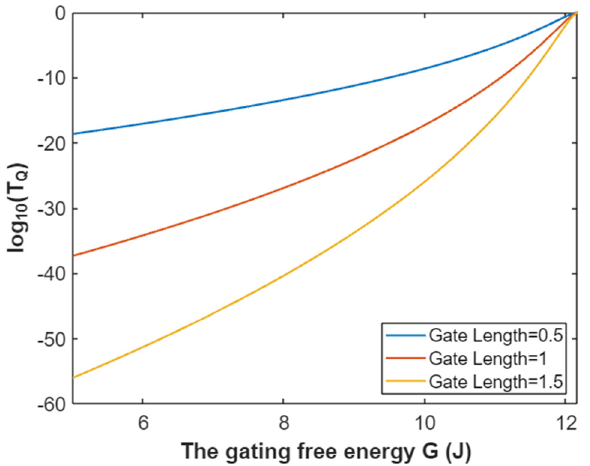
Figure 8. The relationship between gating free energy and the common logarithm of tunneling probability of intracellular sodium ions at membrane potential of 0.087 V and over a gating free energy range from 5 J to 12.17 J.